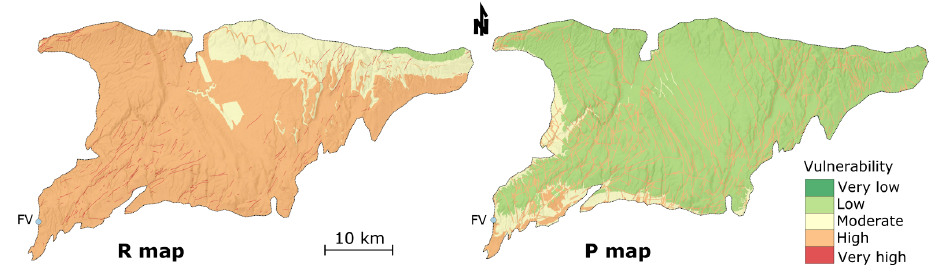
Figure 5. The two karst aquifer structure criteria (R and P) used in the PaPRIKa method for the study